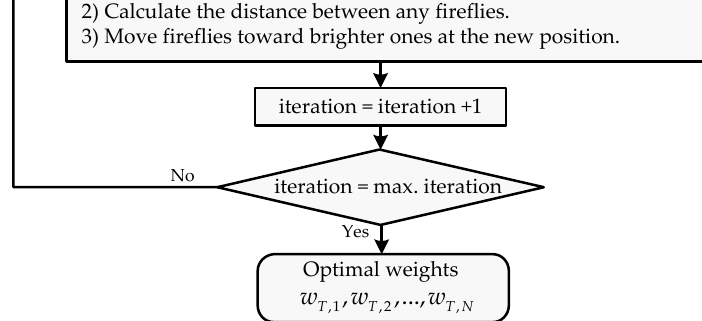
Figure 7. The procedure of FA-based temperature weight